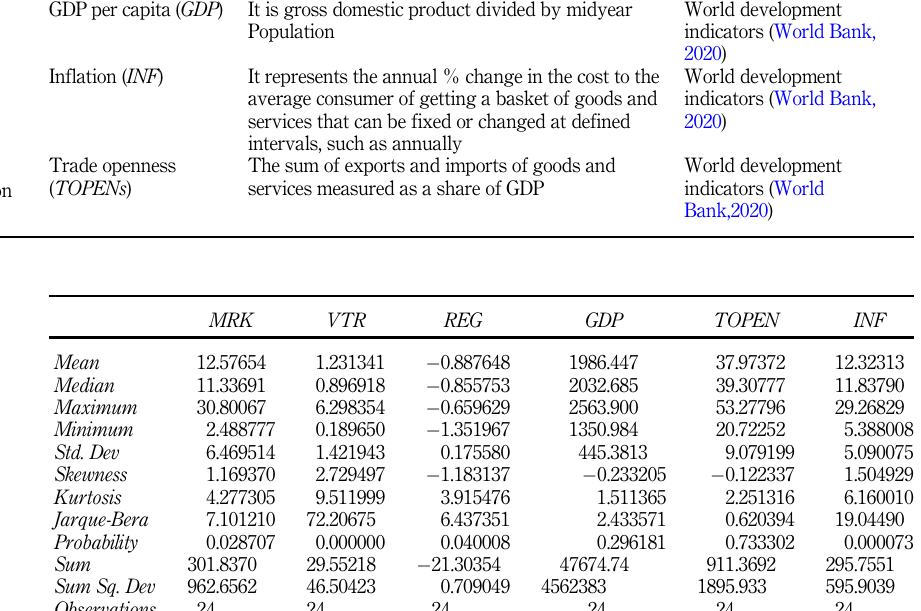
Table 4. Summary